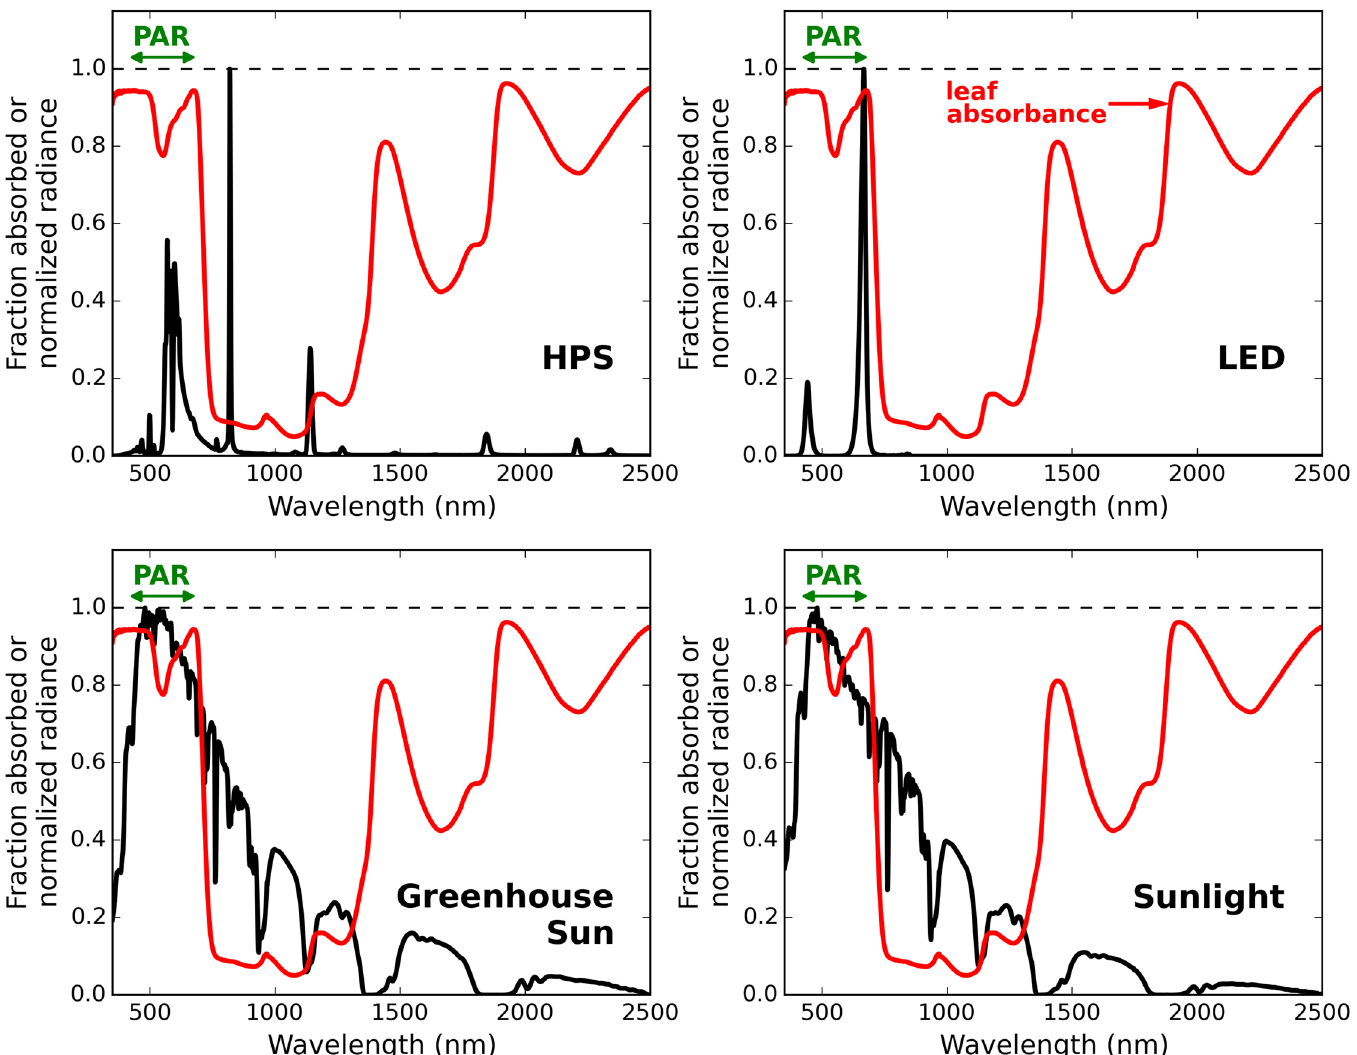
Fig 2. Radiance spectrum from four radiation sources (black line) and average leaf absorbance (red line). Electric lights (HPS and LED) output most of their radiation in the photosynthetic regions. Sunlight has significant NIR radiation, but this is poorly absorbed by leaves.